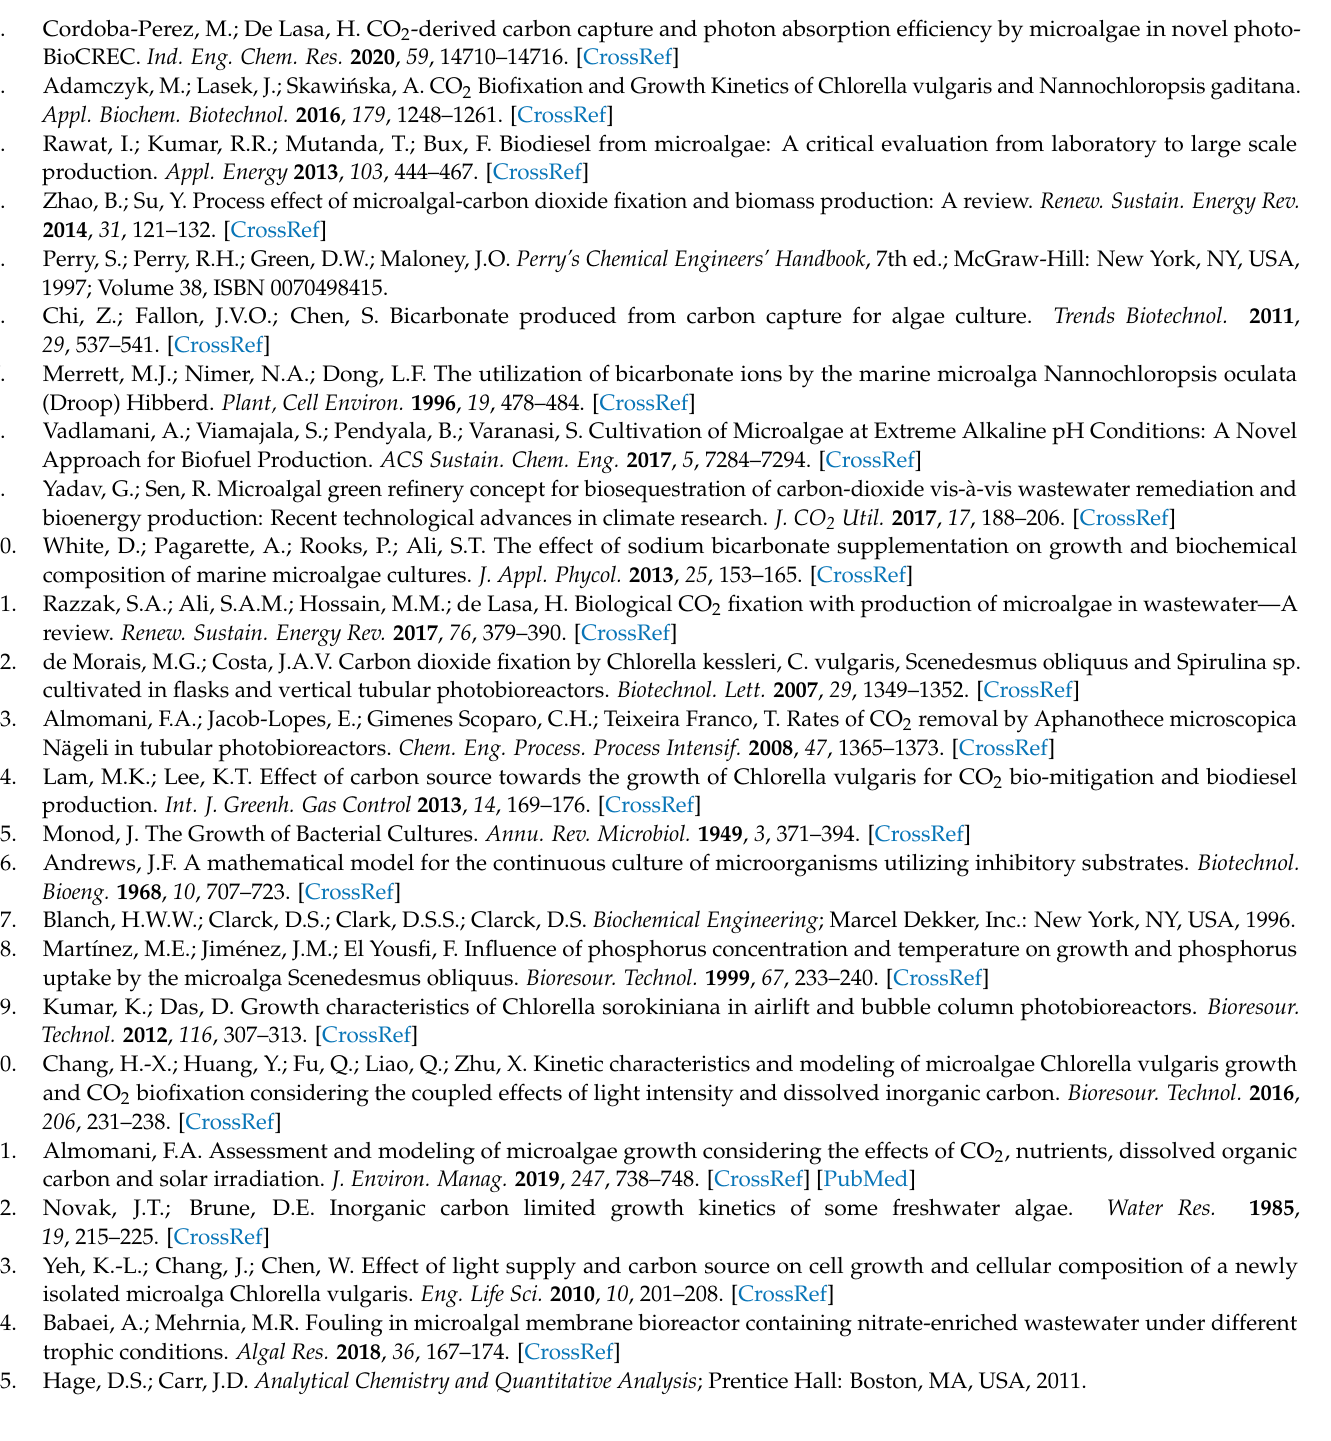
(c) During the stationary phase: t > t lag , Thus, and as shown here, the Heaviside step function provides the solution for the three phases of microalgae